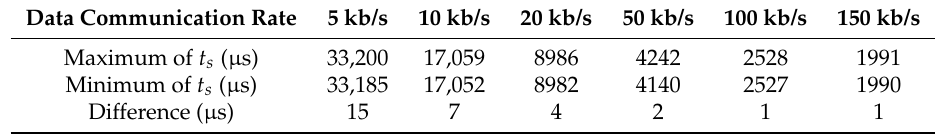
Table 1. The statistics of the time synchronization experiment with different communication